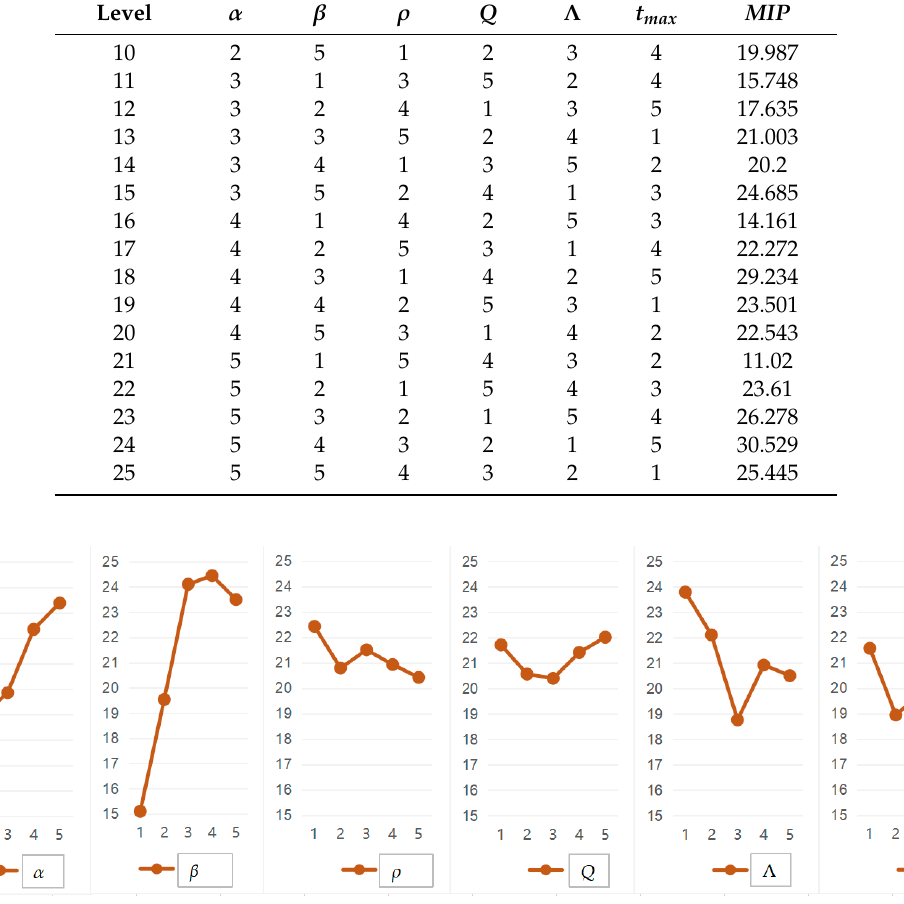
300 Table A4. ACO algorithm parameters orthogonal experiment results. Level